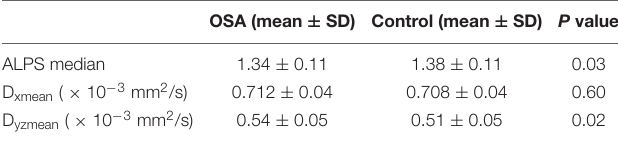
ALPS, analysis along the perivascular space; D xmean , average of diffusivity along the x-axis in periventricular projection and association fiber area; D yzmean , average of diffusivity along the y-axis in periventricular projection and z-axis in association fiber area; OSA, obstructive sleep apnea; IQR, inter-quartile range; SD, standard